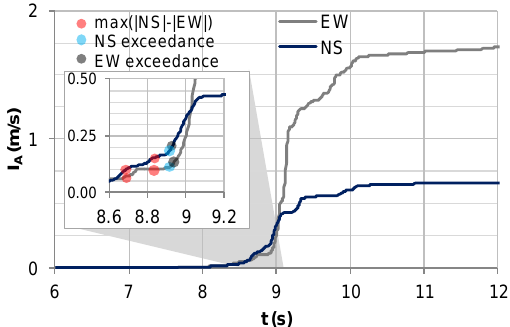
Figure 6. Arias Intensity of the NS and EW compo- nents, recorded in